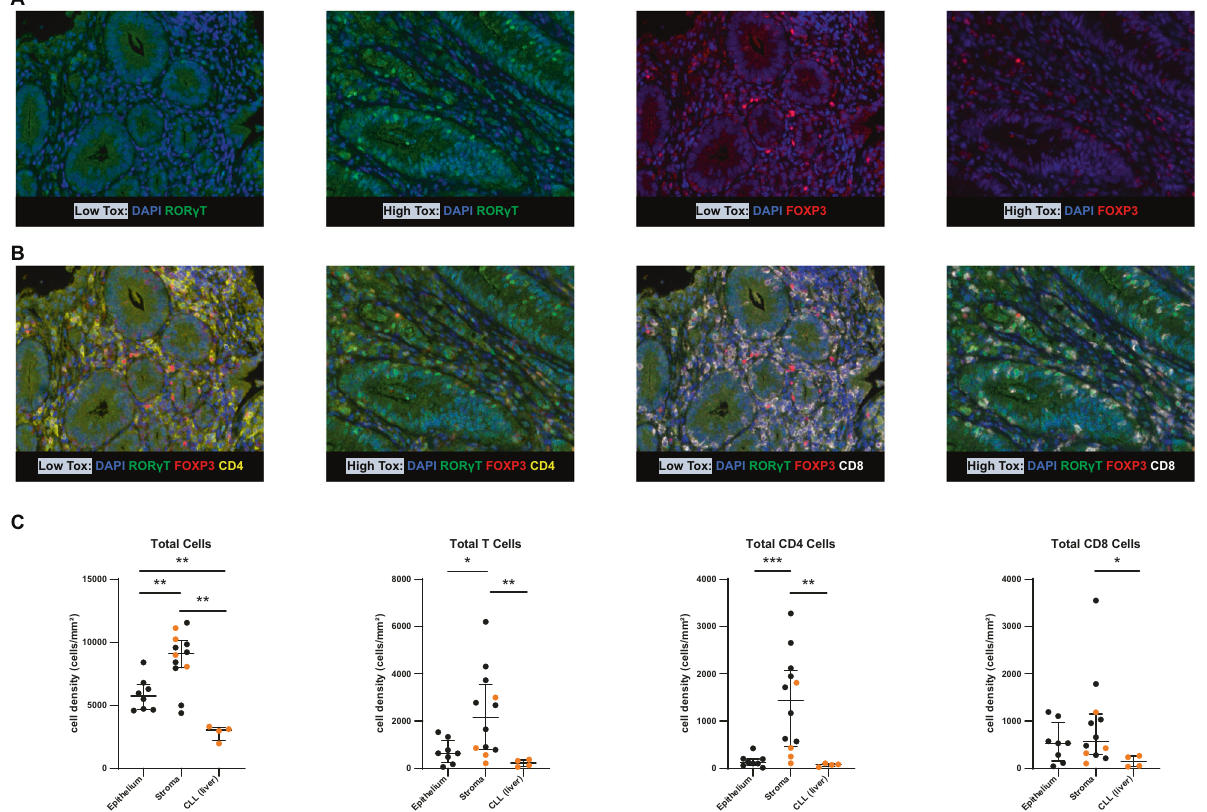
Fig. 5 Multiplex immuno fl uorescence demonstrates tissue in fi ltration with CD4 + and CD8 + T Cells. A Representative images of colon with low and high toxicity demonstrating co-staining of ROR γ T cells and DAPI (left) or with FOXP3 and DAPI (right). B Representative images of colon with low and high toxicity demonstrating co-staining of CD4 (left) and CD8 (right) T cells with the other markers as above. C Quanti fi cation of cellular in fi ltration in each tissue compartment, showing epithelium, stroma and CLL in fi ltration in liver, measured by cell density. Represented are total cells, total T cells, total CD4 T cells and total CD8 T cells. The total cell graph includes CD4 + and CD8 + T cells plus other cells, including macrophages, fi broblasts, and normal epithelial cells. The total T cell graph includes only CD4 + and CD8 + T cells. Results from liver biopsies are in orange, while GI biopsies are in black. * p ≤ 0.05; ** p ≤ 0.01; *** p ≤